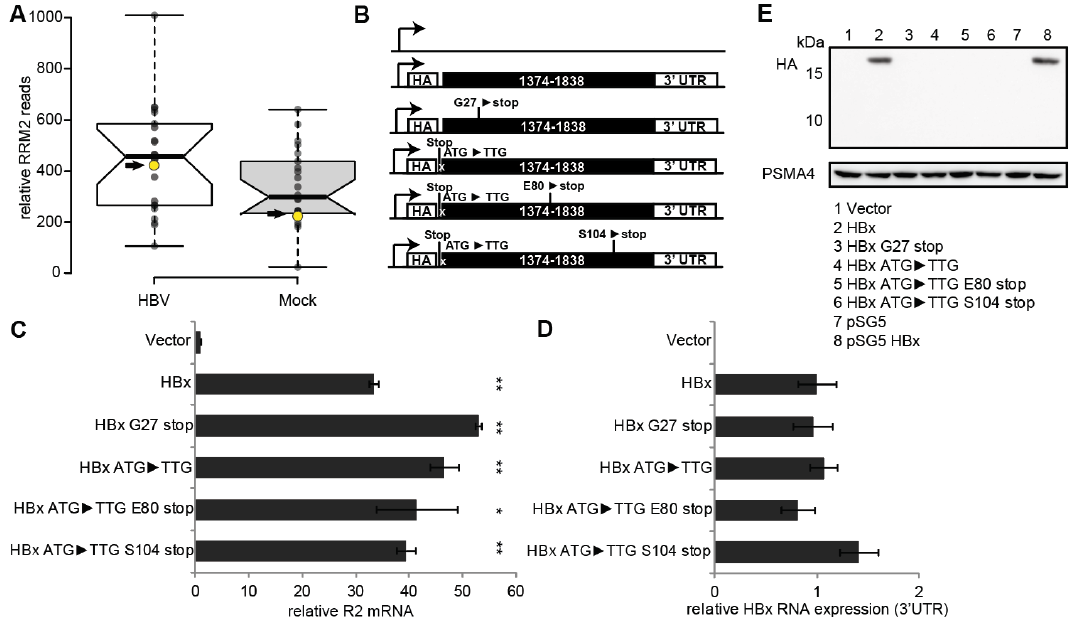
Figure 1. Non-coding HBx ORF transcripts elicit RNR-R2 upregulation in non-cycling cells. ( A ) Boxplot analysis of RNA-Seq data from GSE93153 uploaded by Niu et al. [21] with help of the BoxPlotR web-tool (http://shiny.chemgrid.org/boxplotr/ accessed on 29 November 2021). R2 ( RRM2 ) GSEM reads/total GSEM reads *10 7 of each time point measured were plotted for HBV infected or mock infected PHH. The arrow marks the 4h post infection time point. Center lines show the medians; box limits indicate the 25th and 75th percentiles as determined by R software; whiskers extend 1.5 times the interquartile range from the 25th and 75th percentiles, outliers are represented by dots. n = 22 sample points. We performed Student’s t -test on the both normalized sample sets and the p -value is 0.05689. ( B ) Schematic depiction of the HA-tag-HBx ORF (black regions) with the inserted mutations, all cloned into a Lenti-vector (LV). The HBV 3′UTR was added as a common RNA element for normalization. An empty lenti-vector was used as negative control. ( C , D ) Non-cycling HepG2 cells were transduced with the HBx gene mutants of panel B and relative level of the expressed R2 RNA ( C ) and lentiviral construct expression (3′UTR) ( D ) were quantified by qRT-PCR. ( E ) The constructs in ( B ) were transfected into HEK293 cells. HA-HBx protein levels were measured by Western blot with anti-HA antibody. PSMA4 was used as a loading control. The pSG5-empty (Stratagene) and pSG5-HA-HBx constructs [24] were used as negative and positive controls respectively. p -value * < 0.05 and ** < 0.01 was calculated for each sample compared to the vector control using Student’s t -test, non-labeled samples are